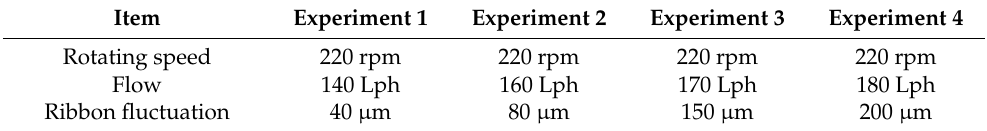
Table 1. Experimental parameters.